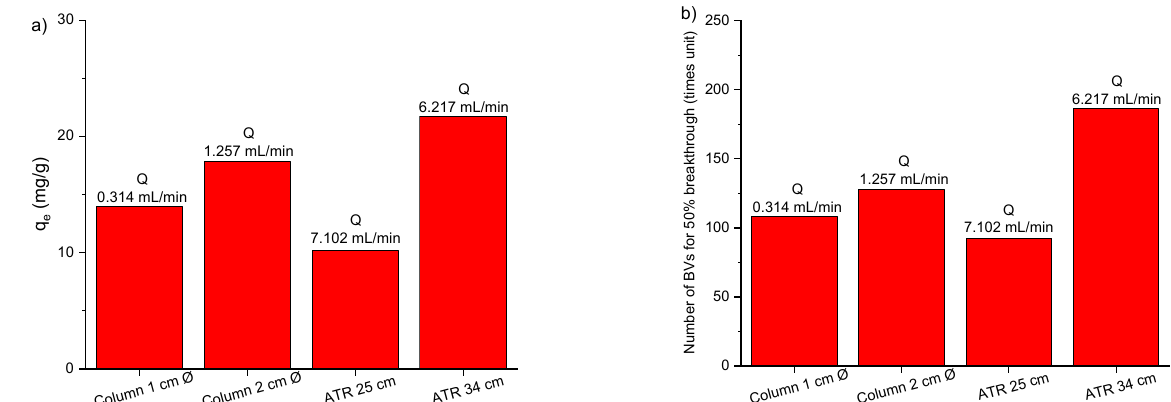
Figure 6. ( a ) The maximum adsorption capacity ( q e ) and ( b ) number of bed volumes (BVs) for a 50% breakthrough ( C e / C 0 = 0.5) for both 1 cm- and 2 cm-diameter ( Ø ) static columns and the agitated tube reactor (ATR) for two different column lengths. All the data for strontium are at a 100 ppm concentration and a 15 min residence time.